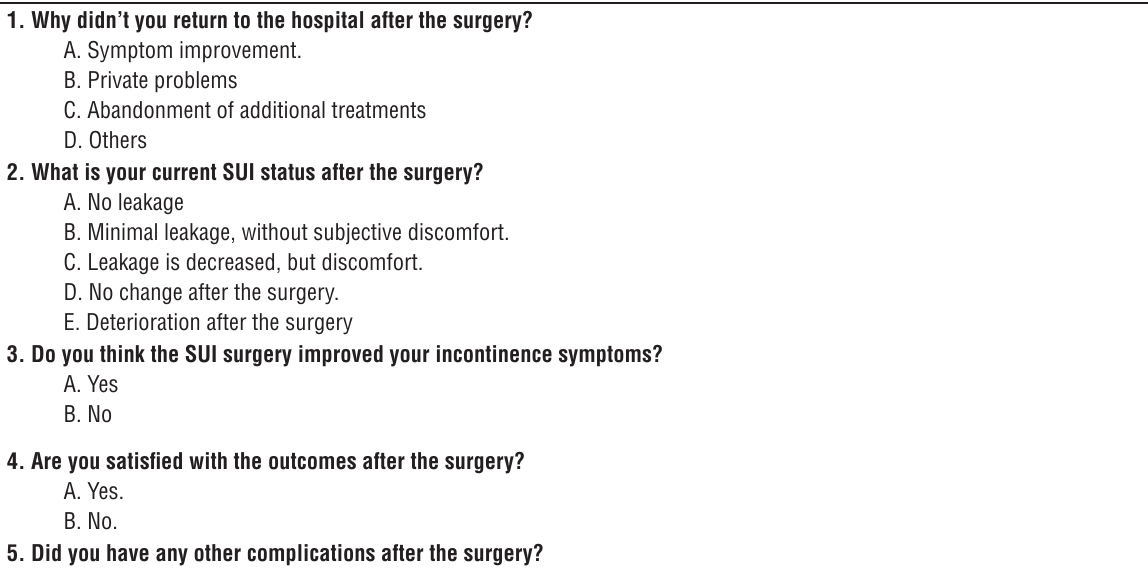
Table 1 - Telephone interview questionnaire for follow-up loss